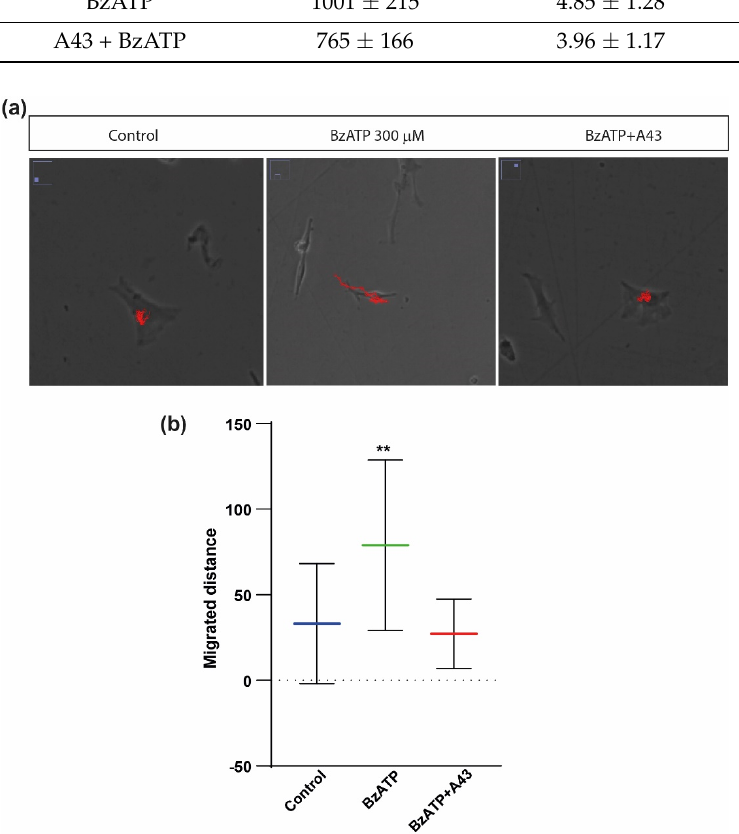
Figure 3. Effects of BzATP treatment on migratory capacity of rat cerebellar astrocytes. ( a ) Bright field images of astrocytes obtained after 3 h of time-lapse video microscopy in control astrocytes and astrocytes treated with 300 µM BzATP in the presence or absence of the antagonist A43. ( b ) Histogram showing the distance travelled in pixels by the astrocytes during a period of 3 h, in basal conditions, or after incubation with BzATP for one hour, in the presence or absence of antagonist A43. Whiskers indicate SD; statistically significant differences were calculated by employing a one-way ANOVA with Dunnett’s post-test and are indicated by ** when p < 0.01.